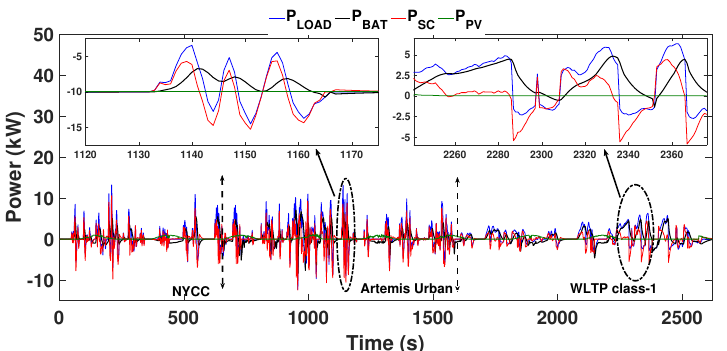
Figure 11. Comparison of battery, SC, PV, and load power (BEV) with